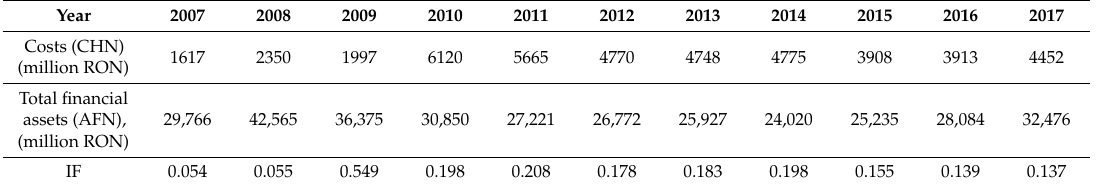
Table 4. Asset formation indicator (IF) values for the period 2007–2017.